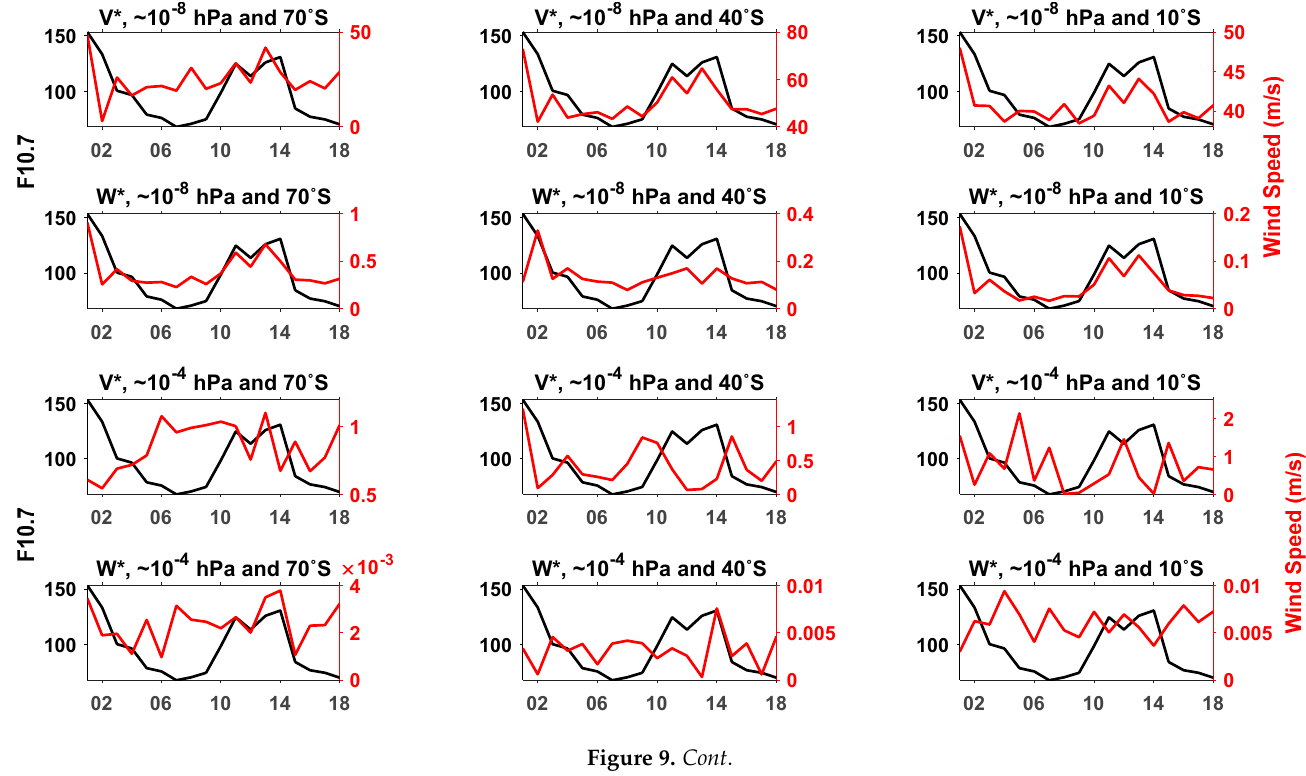
Figure 8. Atmospheric circulation in December ( a , b ) 2002 and ( c , d ) 2009. ( e , f ) Differences in the atmospheric circulation in December between 2002 and 2009. Left and right panels show the atmospheric circulation in the global atmosphere and in the middle and lower atmosphere, respectively.